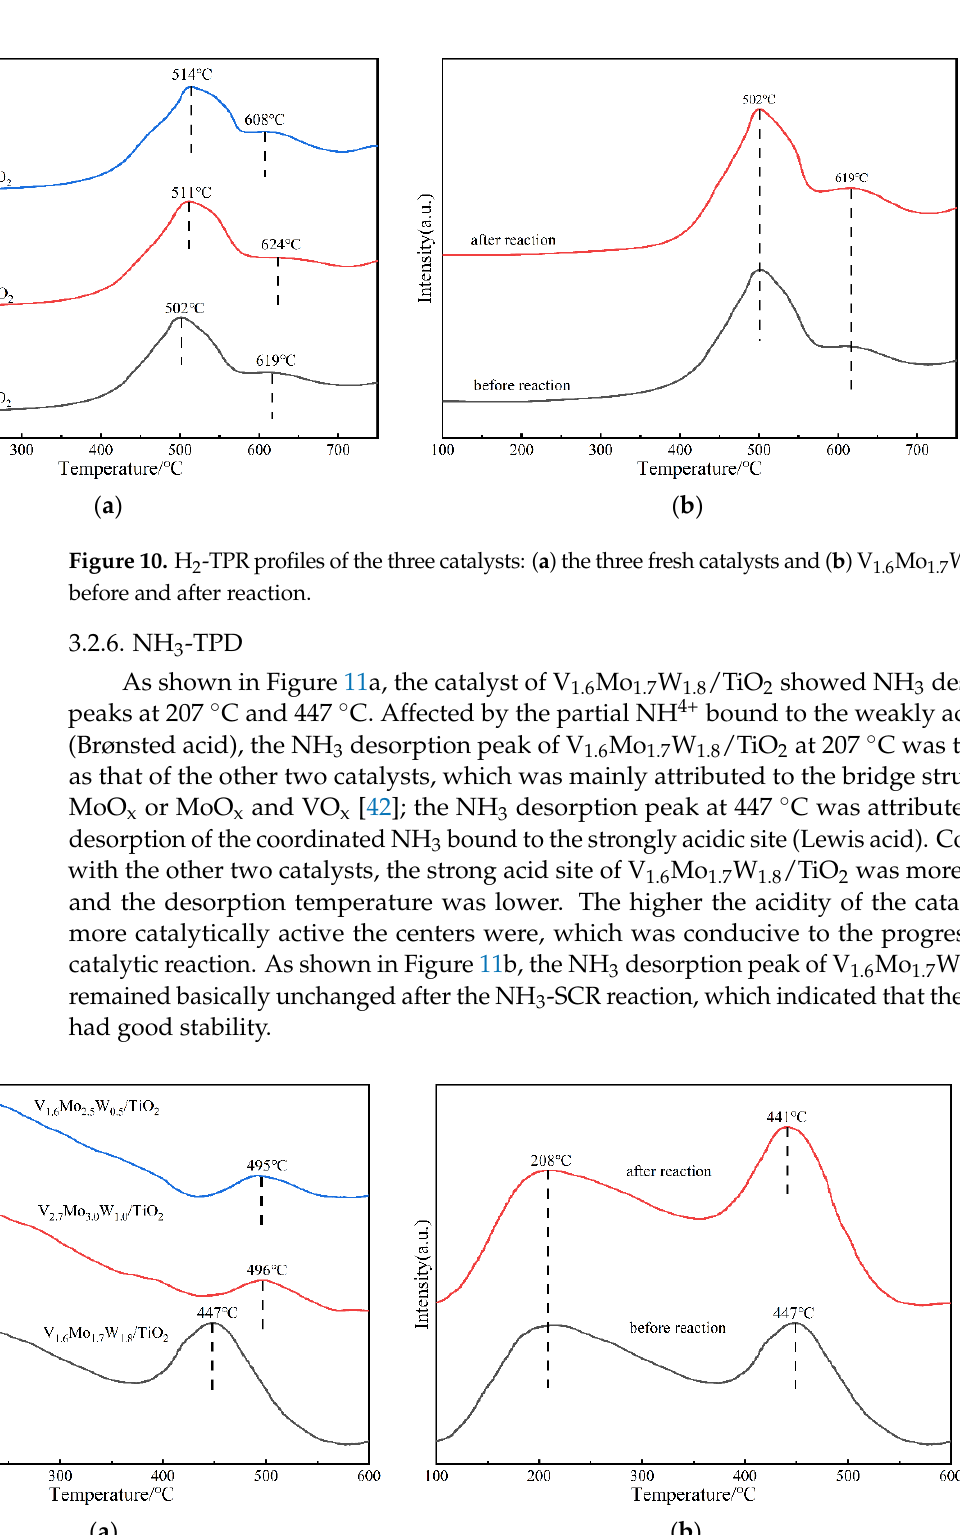
10 of 13 Figure 9. Deconvoluted XPS spectra of the V 1.6 Mo 1.7 W 1.8 /TiO 2 before and after reaction: ( a ) O1s; ( b ) Mo3d; ( c ) V2p. Table 2. The chemical states and the ratios of the relative concentrations of O, V, and Mo for different catalysts. Catalyst